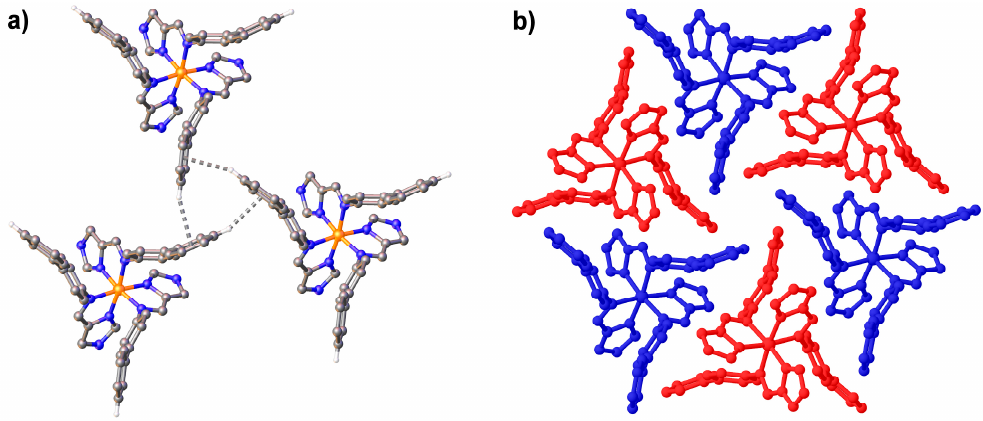
Figure 4. View of the ( a ) intermolecular C–H ⋅⋅⋅π interactions that link the ( b ) Λ (blue) and ∆ (red) fac -[Fe(4-ima-Bp) 3 ] 2+ cations that form the hexagonal motif in 1 .